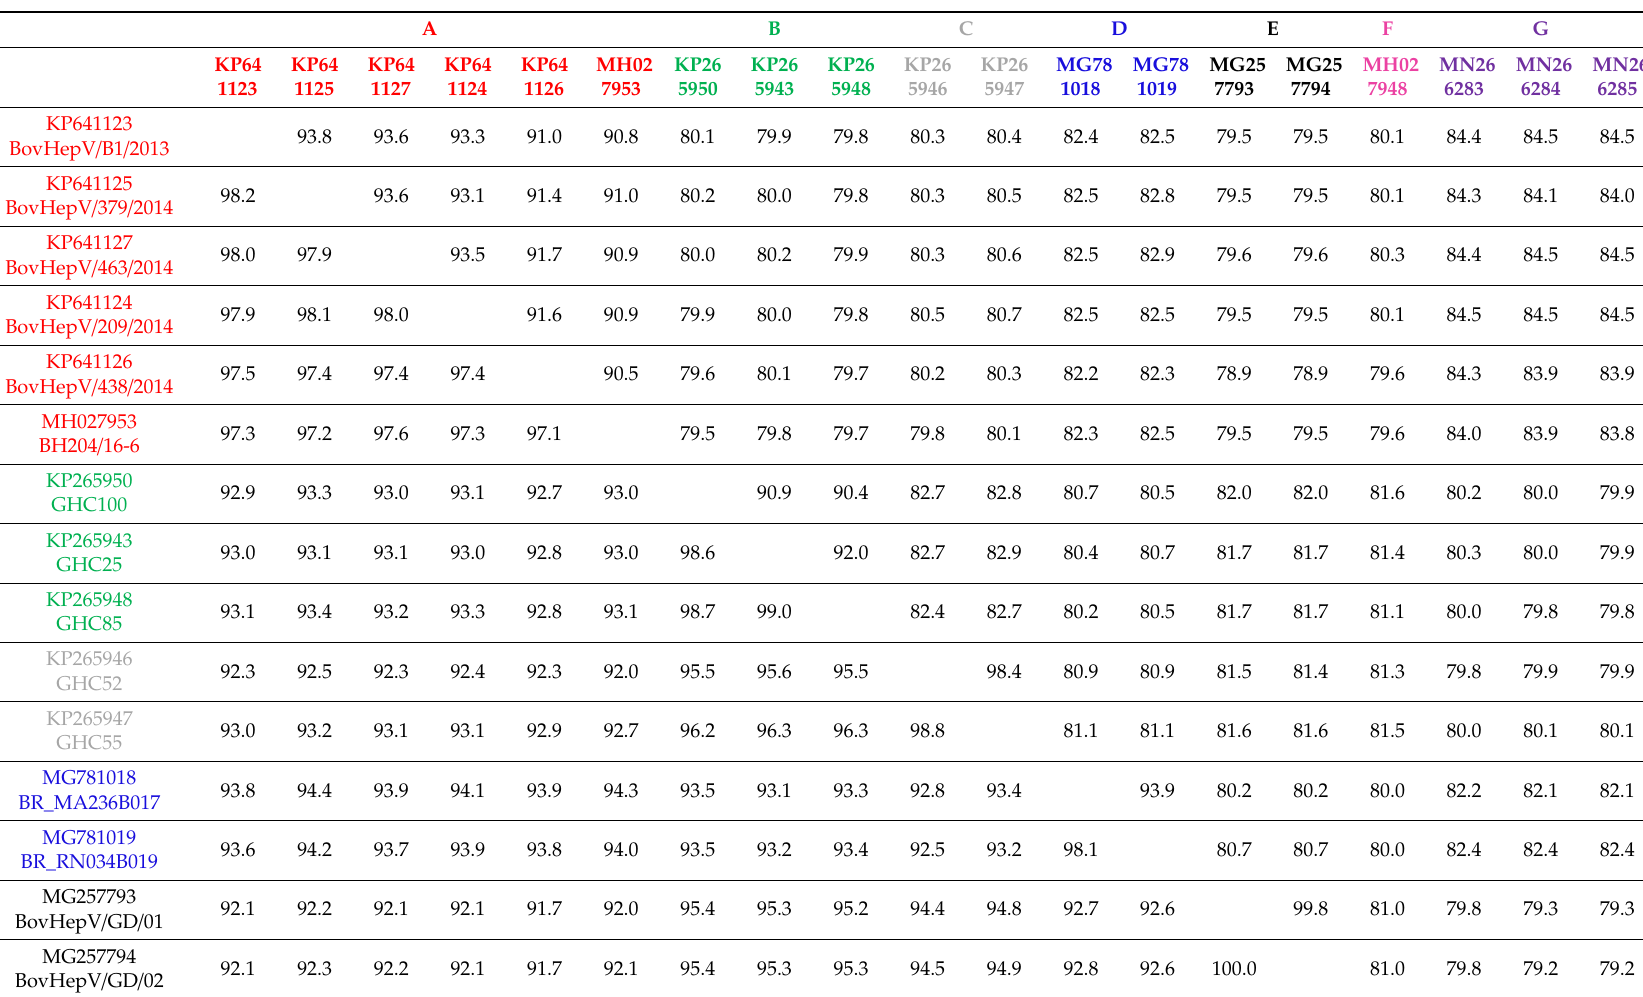
Table 3. The sequence identity within the BovHepV polyprotein gene at the nucleotide (upper right) and amino acid (lower left) levels. The strain names and accession numbers of the BovHepV strains of subtypes A–G are shown in di ff erent colors. The sequence identity was calculated using MegAlign